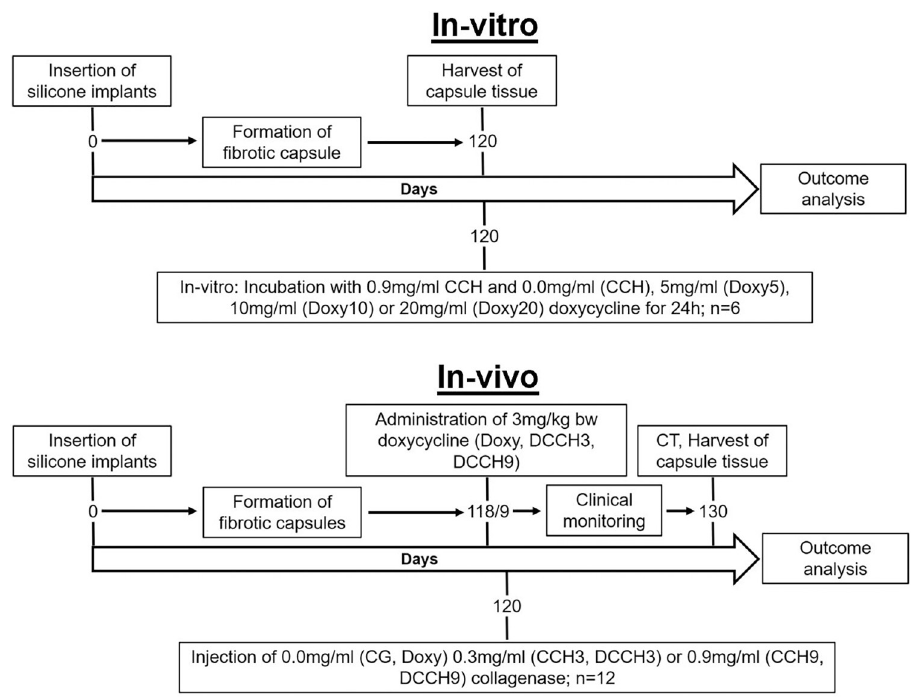
Fig 2. Illustration of study design. Study design for in-vitro and in-vivo experiments. CCH = collagenase of the bacterium C. histolyticum. Group size was n = 6 for in-vitro and n = 12 for in-vivo experiments. Outcome analysis included clinical monitoring, skin and capsule thickness and collagen density measurements, collagen content determination and gene expression analysis.